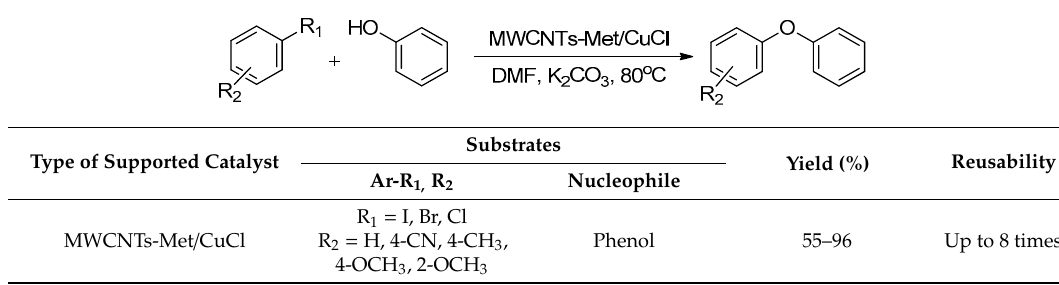
Table 4. The MWCNTs-Met/CuCl catalyzed synthesis of biphenyl ethers.